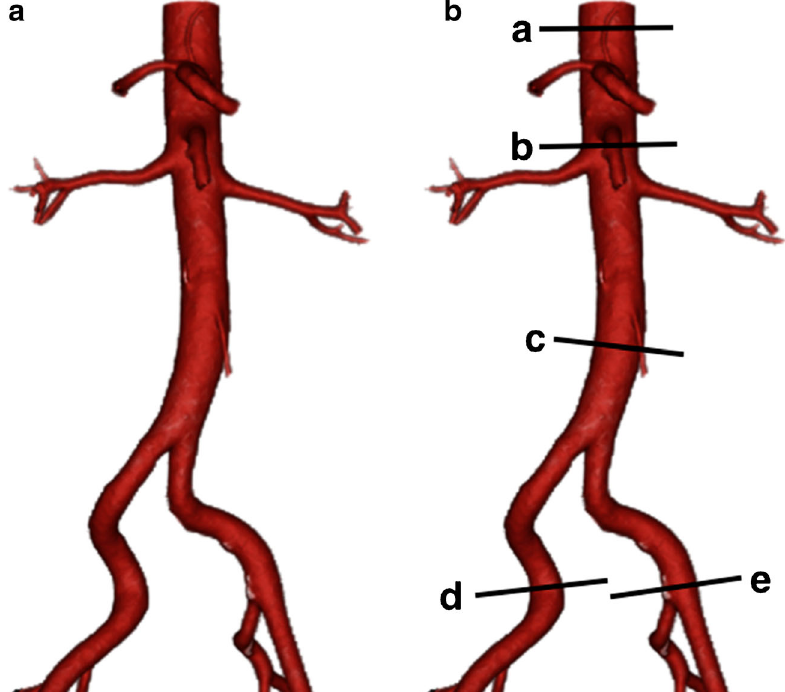
embolisation (Fig. 9) [76, 77]. When performing multiphasic aortic CTA using a DECT system, reconstruction of a virtual non-contrast image may obviate the need to acquire a separate non-contrast CT [41, 42]. For patients undergoing post-EVAR CTA follow-up to detect endoleak, use of a split-bolus injec- tion technique has the potential to reduce radiation dose, by